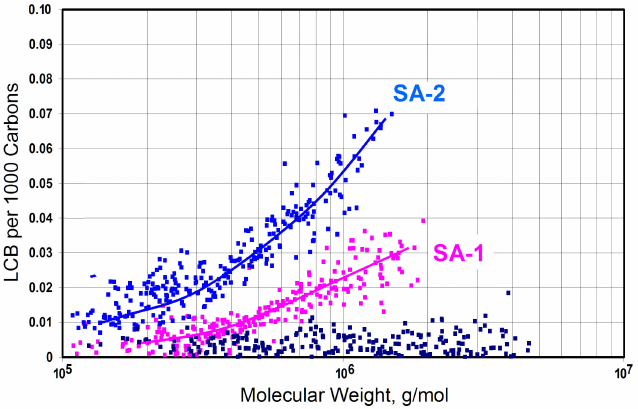
Figure 6. Light scattering analysis (SEC-MALS) of polymers from metallocene on two different solid acids: SA-1 (sulfated alumina) and SA-2 (fluorided